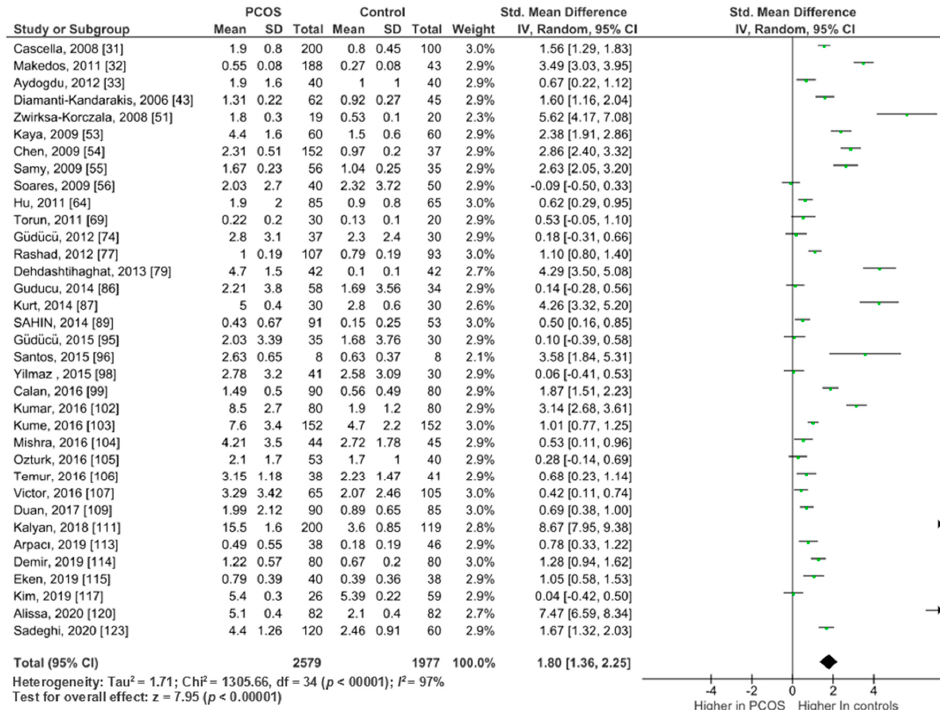
98%). (Figure 4). The magnitude of this difference was smaller than that between of nor- mal weight groups.